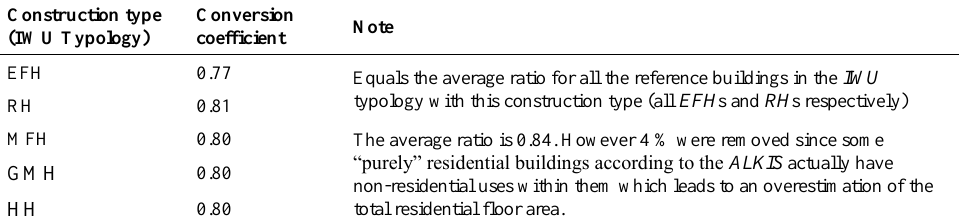
Construction type (IWU